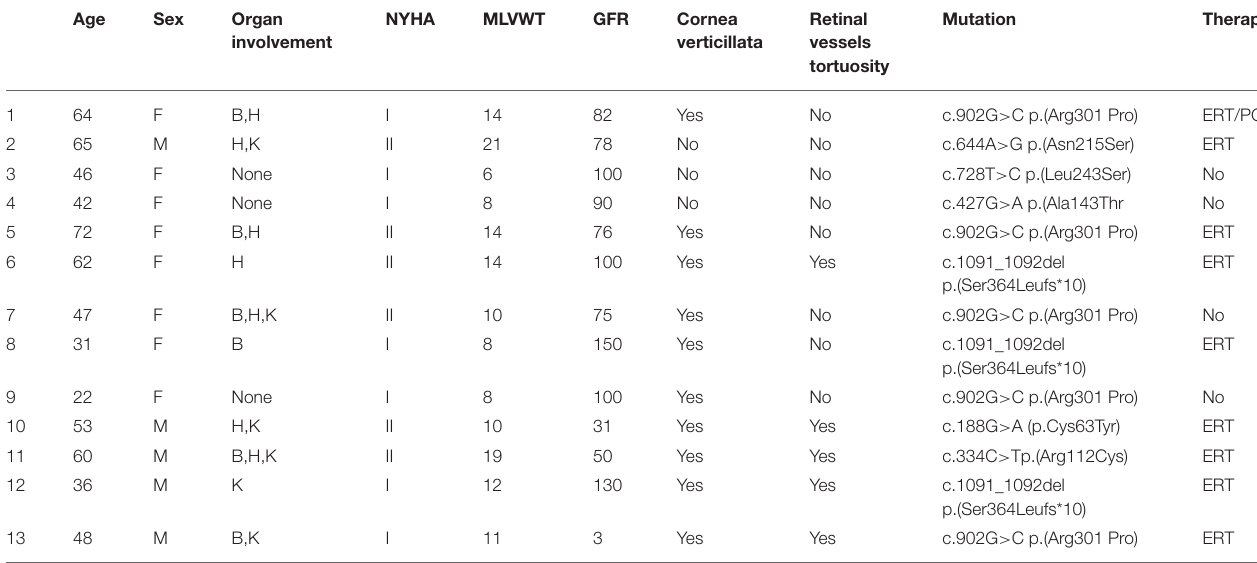
TABLE 1 | Demographics and clinical data of the patients with Fabry